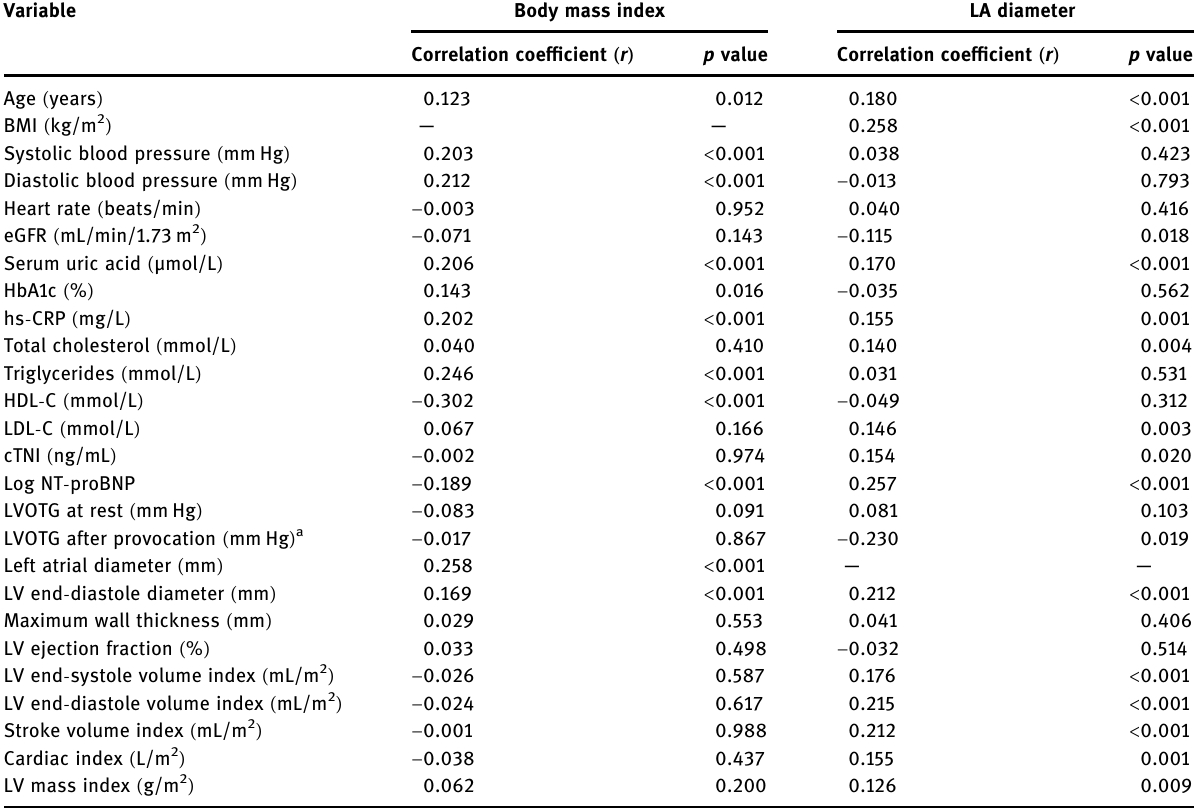
Table 2: Univariable analysis of correlation between variables and BMI and LA diameter